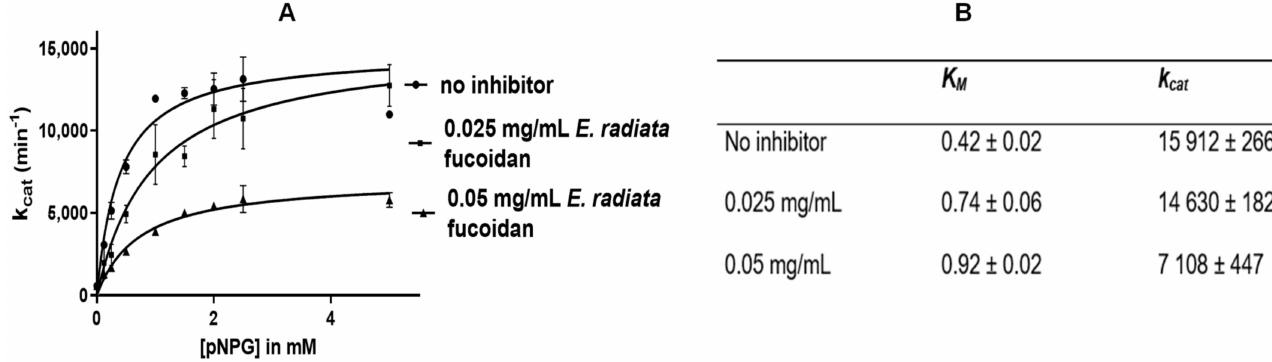
Figure 6. Kinetic parameters for α -glucosidase inhibition. ( A ) Michaelis Menten curve for E. radiata fucoidan and ( B ) Kinetic parameters to determine the mode of inhibition of E. radiata fucoidan on α -glucosidase. Values are repre- sented as means ± SD ( n